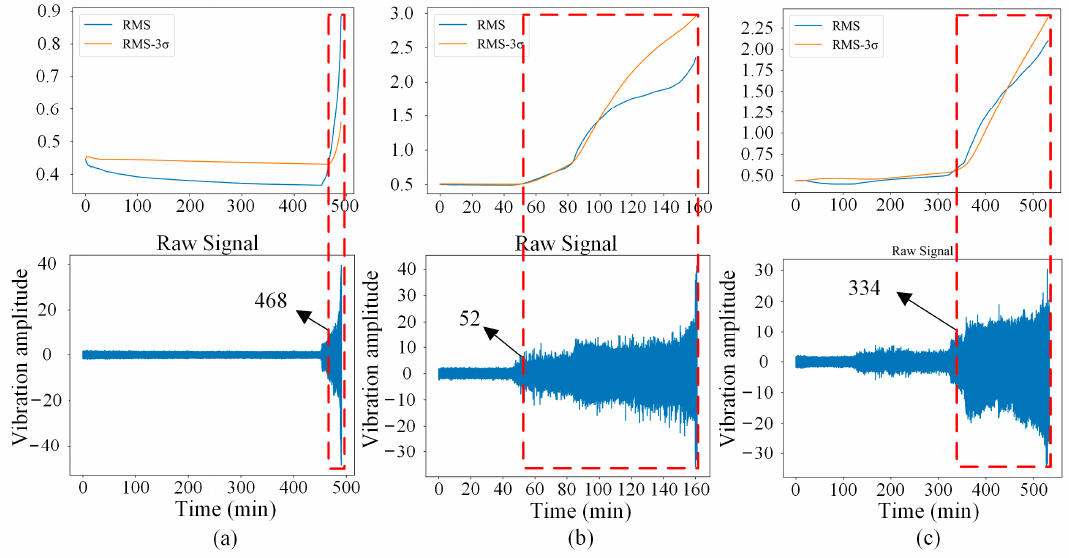
Figure 8. Signals and initial failure point of each fault. ( a ) IRF, ( b ) ORF, ( c ) BCF. It is well known that each sample should contain at least one circle sampling